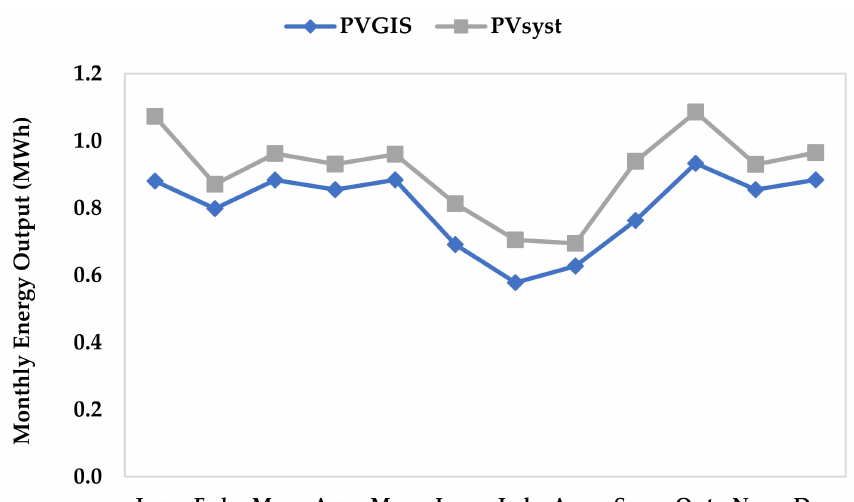
Figure 24. Comparison of PVGIS and PVsyst monthly outputs.